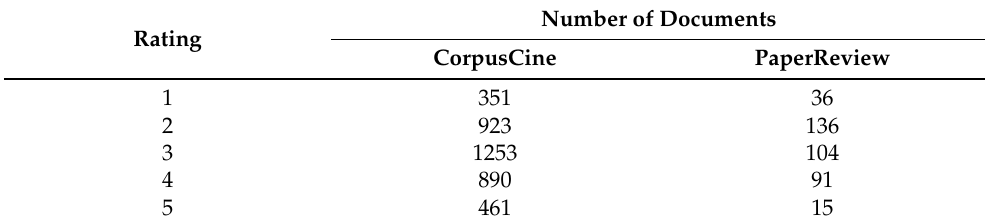
Table 1. Rating distribution for the labeled